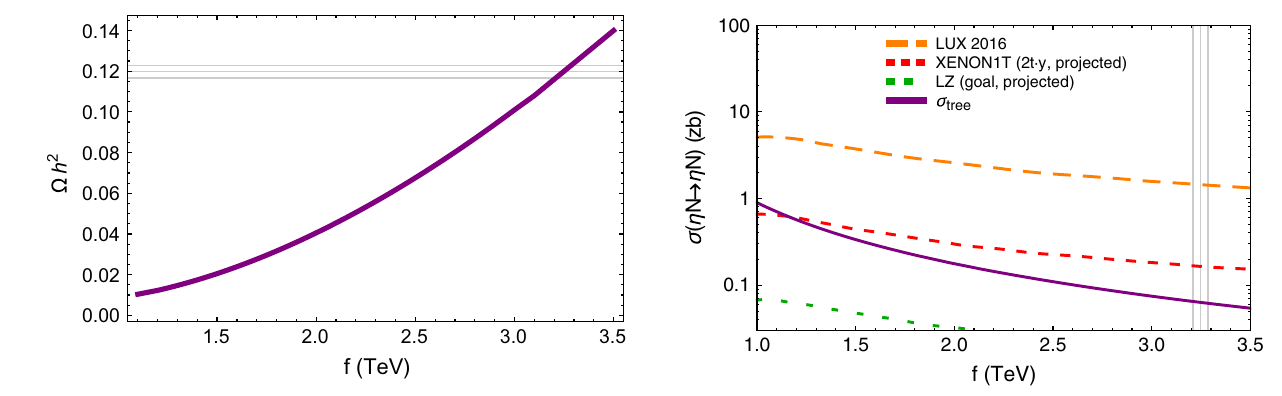
Fig. 5 The dependence of the relic abundance (cid:23) h 2 in the singlet case asafunctionofthecompositenessscale f .The horizontallines showthe measured central value and a 95% C.L. interval around it as determined by Planck [34] 3 − i ˜ H √